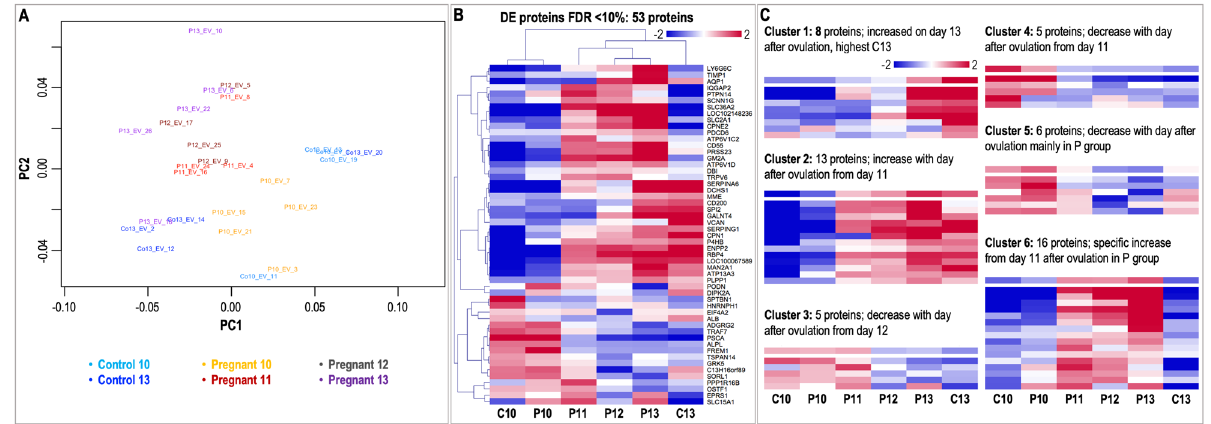
Figure 7. Differential analysis of protein cargo in uEVs across samples. ( A ) Multidimensional scaling (MDS) plot of protein cargo in uEVs derived from pregnant and cyclic control mares. ( B ) Mean-centered log2 intensity values were calculated (value of respective sample – mean of all samples) for proteins differentially abundant (DA) across experimental groups (FDR 10%). Hierarchical cluster analysis (HCL) (Pearson correlation, MeV software) was performed for DA proteins (pregnancy days 10, 11, 12, and 13: P10, P11, P12, and P13; cyclic controls days 10 and 13 post-ovulation: C10, C13). (C) Self-organizing tree algorithm (SOTA) analysis was used to identify clusters of proteins with similar expression profiles. Six clusters containing proteins with similar profiles across experimental groups are shown, with six expression images showing the number of proteins and expression profiles in each SOTA cluster. Vertical axis: mean-centered expression values in log2 scale. MDS plot image was created with Bioconductor package EdgeR (https:// bioco nduct or. org/ packa ges/ relea se/ bioc/ html/ edgeR. html) 91 . HCL image and SOTA expression images were created with Multiple Experiment Viewer